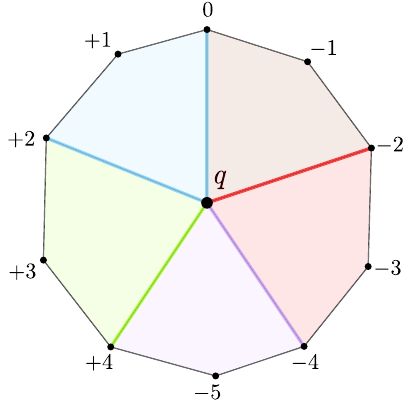
Figure 1: The vertices on the rim of W ˆ n